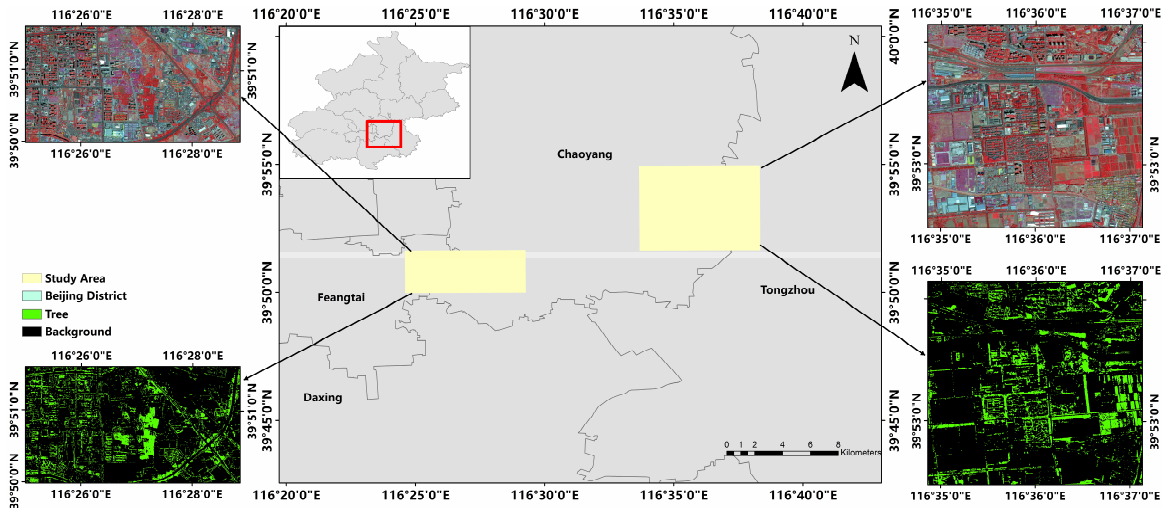
Figure 2. Diagrammatic representation of study area's location and the relevant data used. Satellite images (displayed in 4-3-2 band false color) and corresponding ground truth.